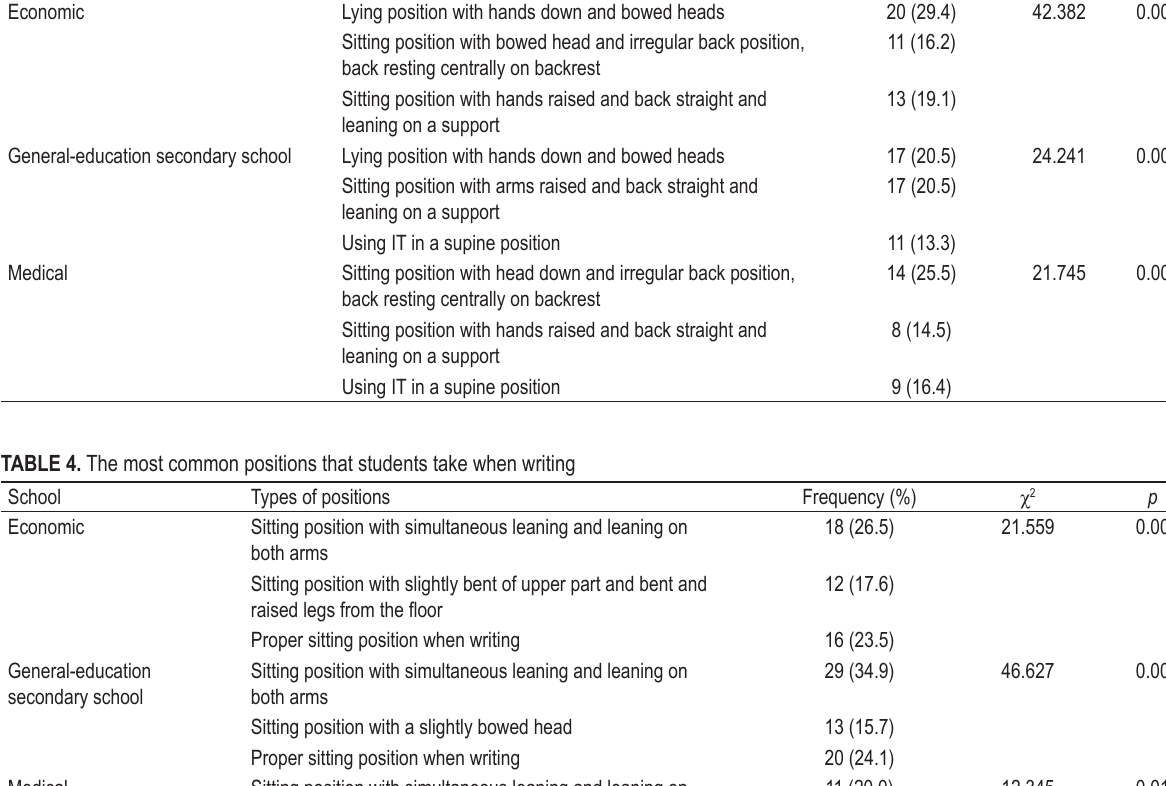
TABLE 3. The most common positions that students take when following online classes and fulfilling school obligations School Types of positions Economic Lying position with hands down and bowed heads Sitting position with bowed head and irregular back position, back resting centrally on backrest Sitting position with hands raised and back straight and